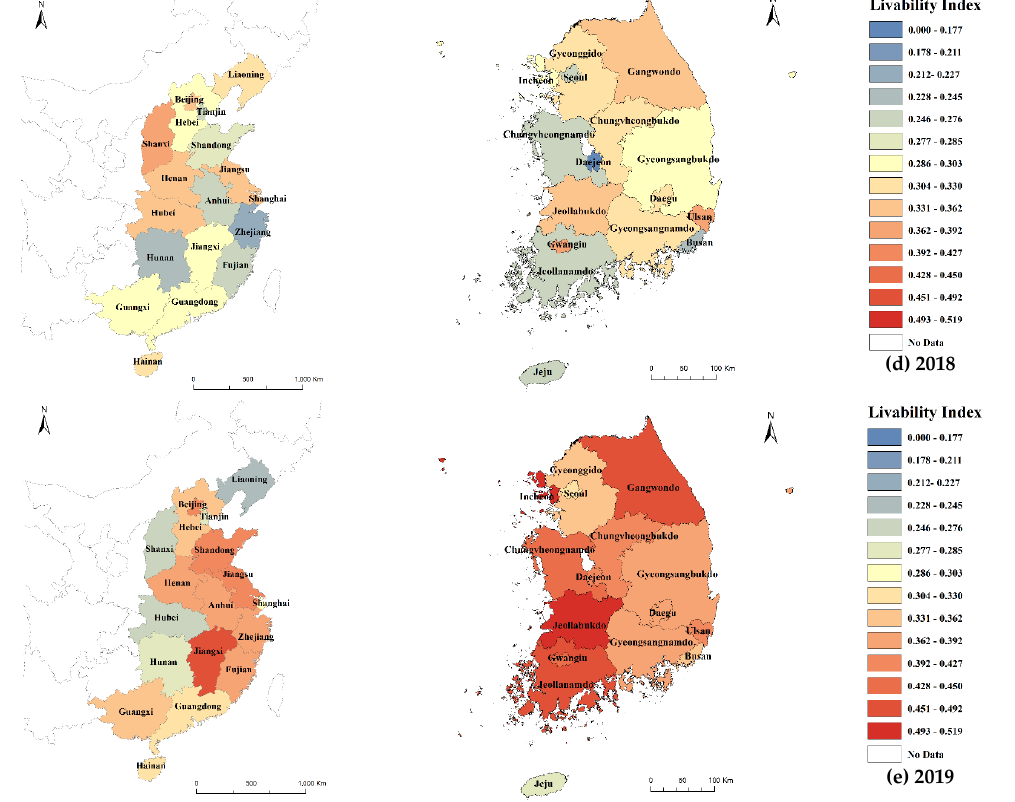
Figure 4. Livability measurement results considering PM (cid:2870).(cid:2873) vulnerability.